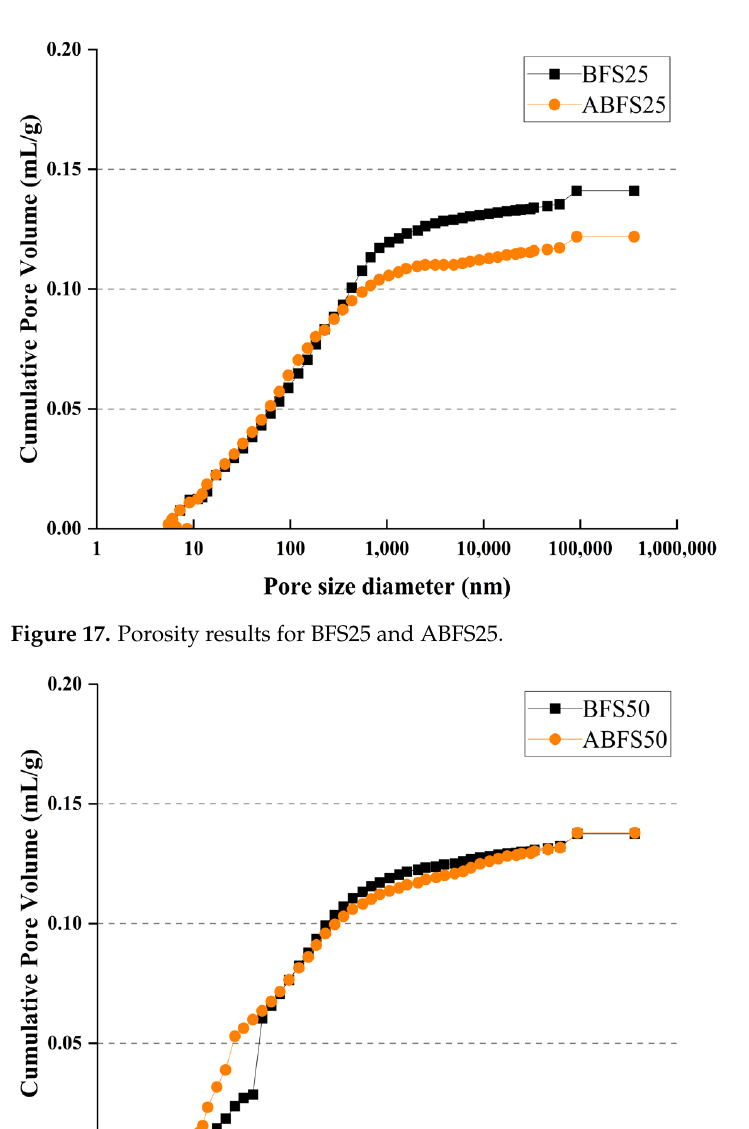
Figure 16. MIP results for BFS50 and ABFS50.